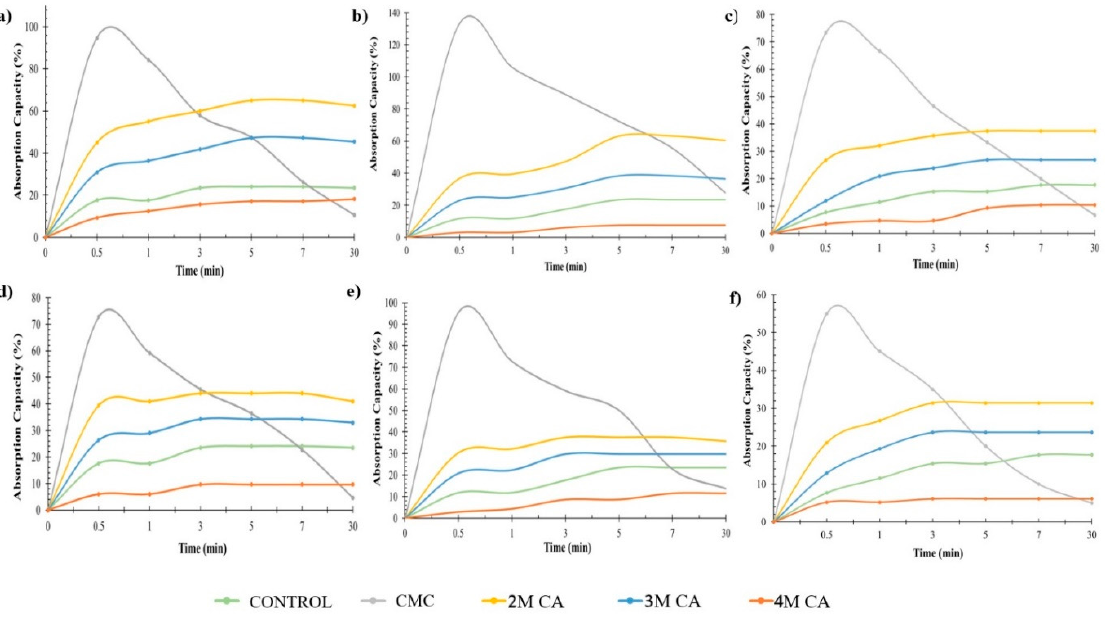
Figure 8. Water absorption behavior of CT/CMC + CA based on different drying methods. ( a ) OD-1, ( b ) IR-1, ( c ) OIR-1, ( d ) OD-2, ( e ) IR-2, and ( f ) OIR-2.